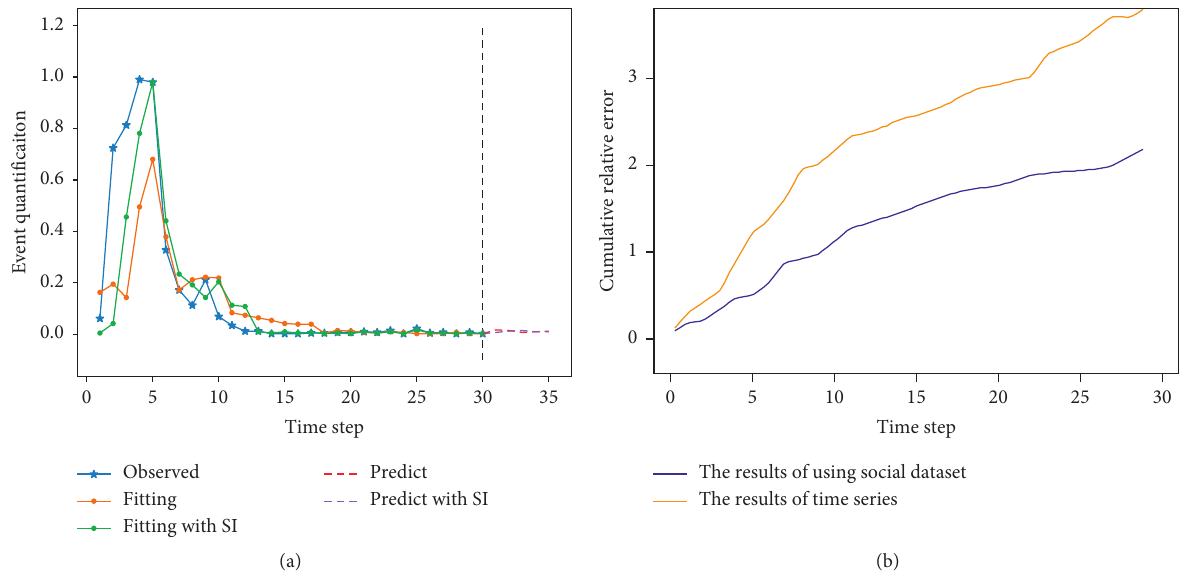
Figure 11: Popularity evolution of international news event: “THAAD.” (a) Prediction accuracy comparison. (b) Cumulative relative error analysis. A similar prediction result is obtained concerning a slightly rising error compared with Figure 9.